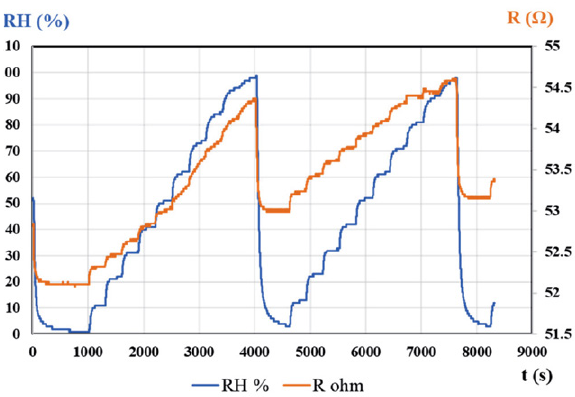
Figure 6. The RH response of the oxidized SWCNHs-based sensor in humid air (red curve) vs the RH response of the Sensirion RH sensor (blue